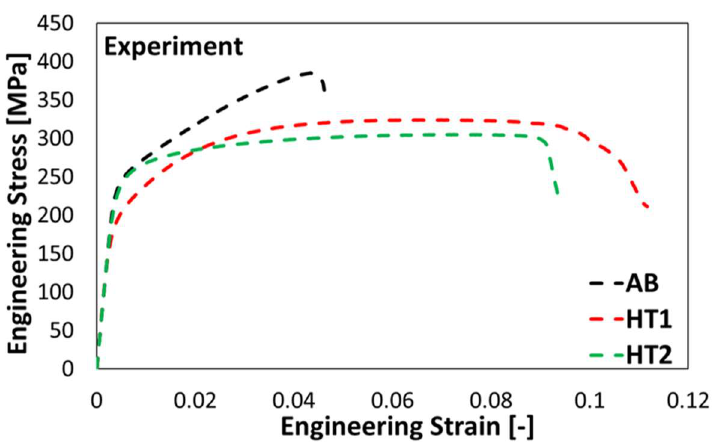
Figure 9. Experimental stress–strain curves of different states for PBF-LB/M AlSi10Mg obtained from uniaxial tensile tests.